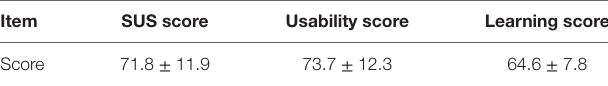
TaBle 5 | Total system usability scale (SUS), usability, and learning scores obtained in the formal